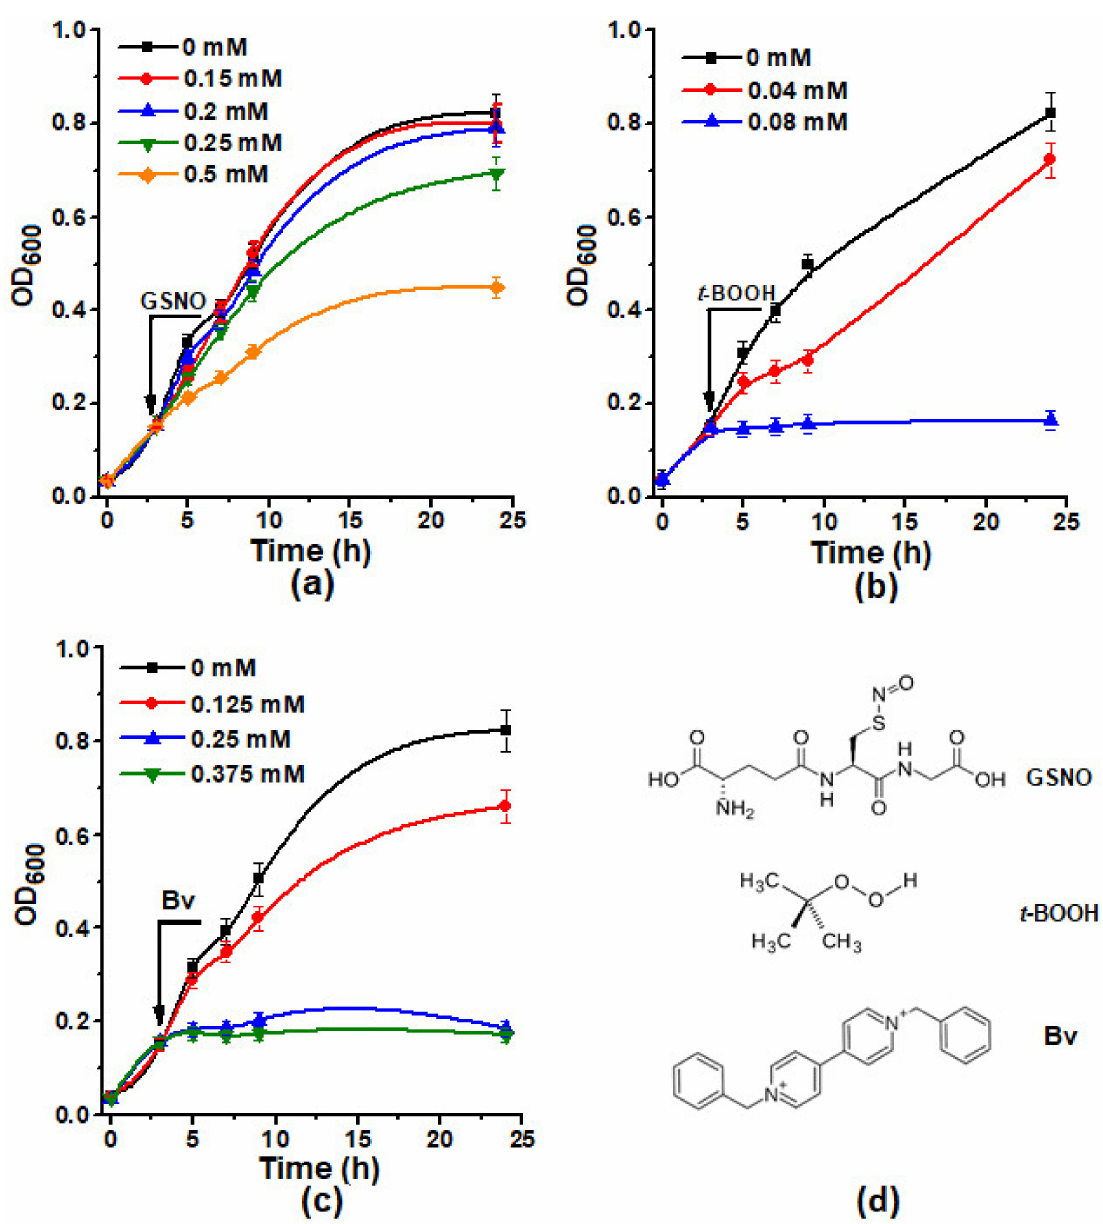
Figure 2. Growth curves of E. coli (C Lb++ ) at different concentrations of S-nitrosoglutathione (GSNO) ( a ), tert -butyl hydroperoxide ( t -BOOH) ( b ), and benzylviologene (Bv) ( c ). Inducers of oxidative and nitrosative stress were added after 3 h of E. coli growth. Structural formulas of GSNO, t -BOOH, and Bv are shown on ( d